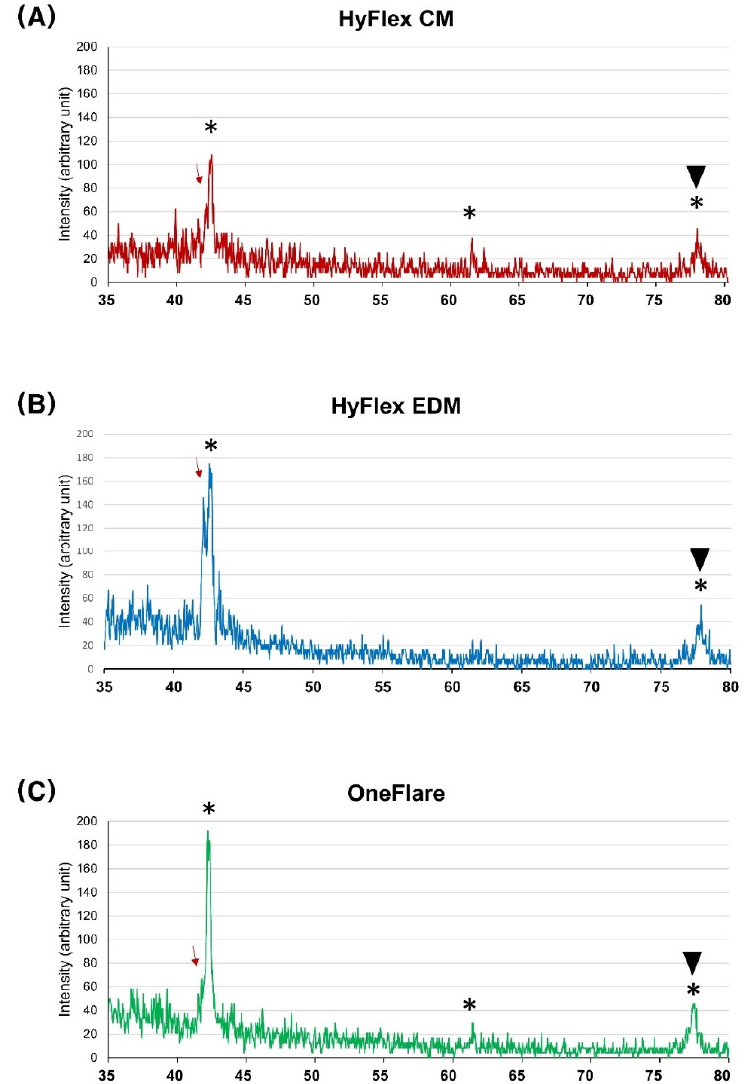
Figure 4. XRD results of HyFlex CM ( A ), HyFlex EDM ( B ), and OneFlare ( C ). Peaks for austenite (*), martensite (arrow) and R-phase (arrowhead) are matched.